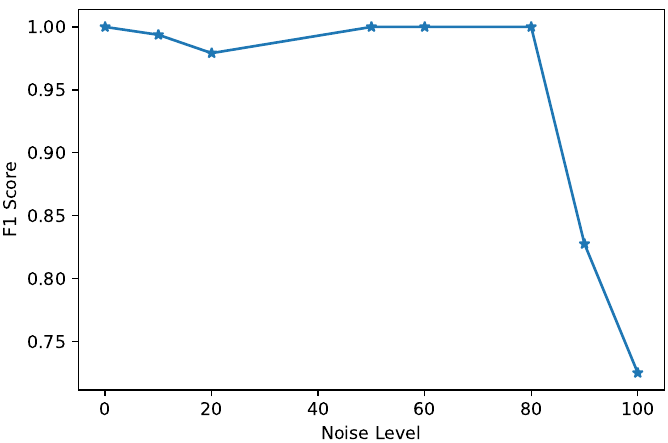
Figure 15. Five-runs averaged accuracy changed with different noise levels